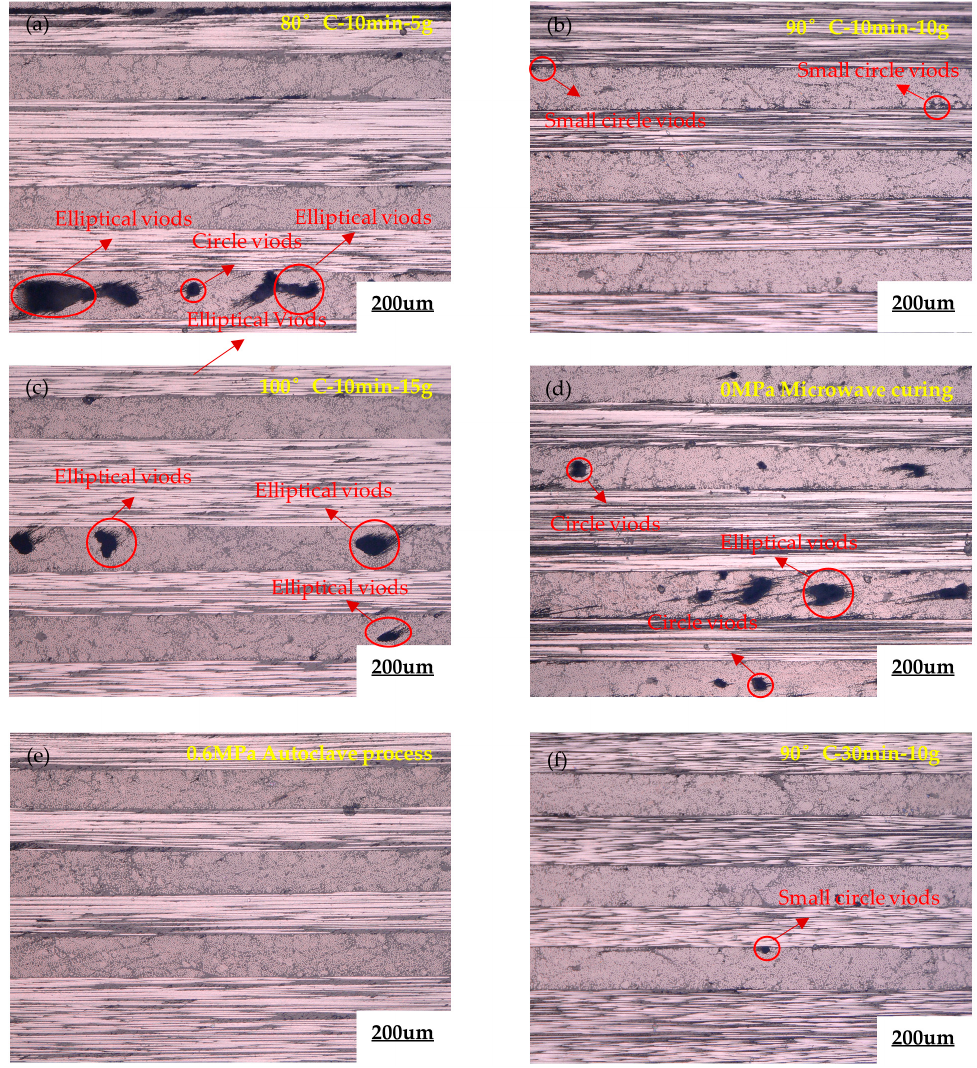
Figure 7. Microscopic morphology of vibration microwave curing process, microwave curing pro ‐ cess, autoclave process, ( a ) 80 °C ‐ 10 min ‐ 5 g microwave curing process, ( b ) 90 °C ‐ 10 min ‐ 10 g mi ‐ autoclave process, ( a ) 80 ◦ C-10 min-5 g microwave curing process, ( b ) 90 ◦ C-10 min-10 g microwave crowave curing process, ( c ) 100 °C ‐ 10 min ‐ 15 g microwave curing process, ( d ) 0 MPa microwave curing process, ( c ) 100 ◦ C-10 min-15 g microwave curing process, ( d ) 0 MPa microwave curing, curing, ( e ) 0.6 MPa autoclave process, ( f ) 90 ‐ 30 min ‐ 10 g microwave curing process. ( e ) 0.6 MPa autoclave process, ( f ) 90 ◦ C-30 min-10 g microwave curing